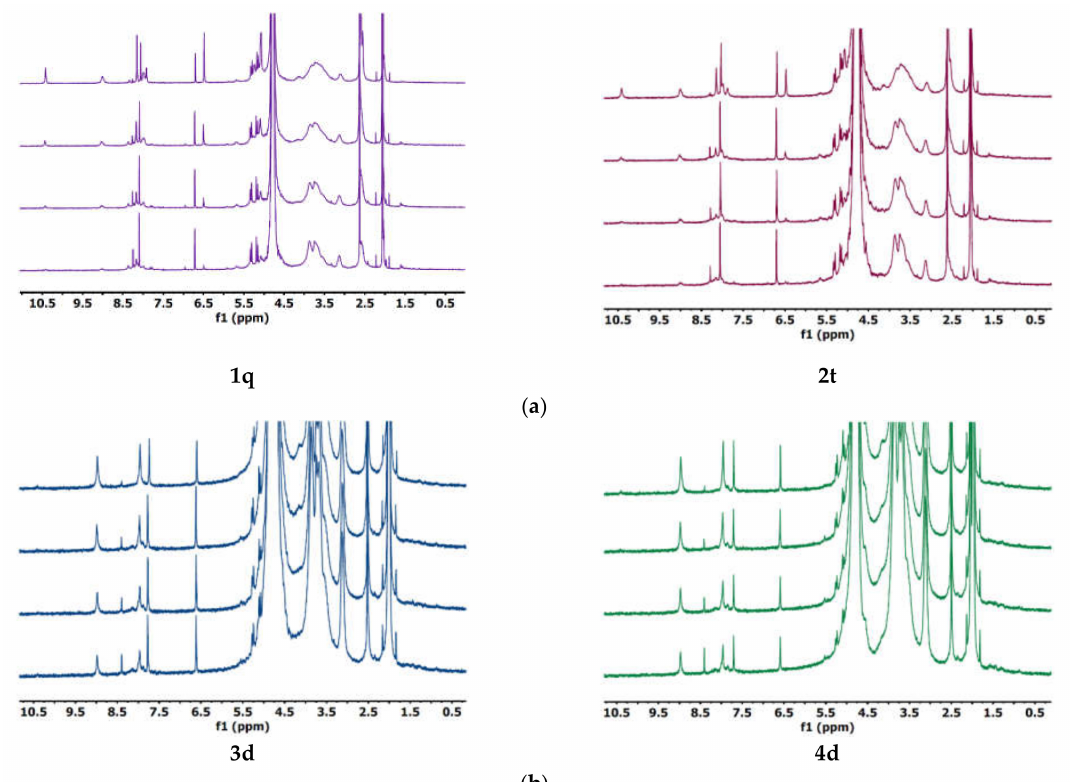
Figure 3. Representative 1 H-NMR spectra of hydrogels ( a ) with higher water content 1q , 2t and ( b ) lower water content 3d , 4d , recorded over time (from up to down: 1, 7, 15, and 22